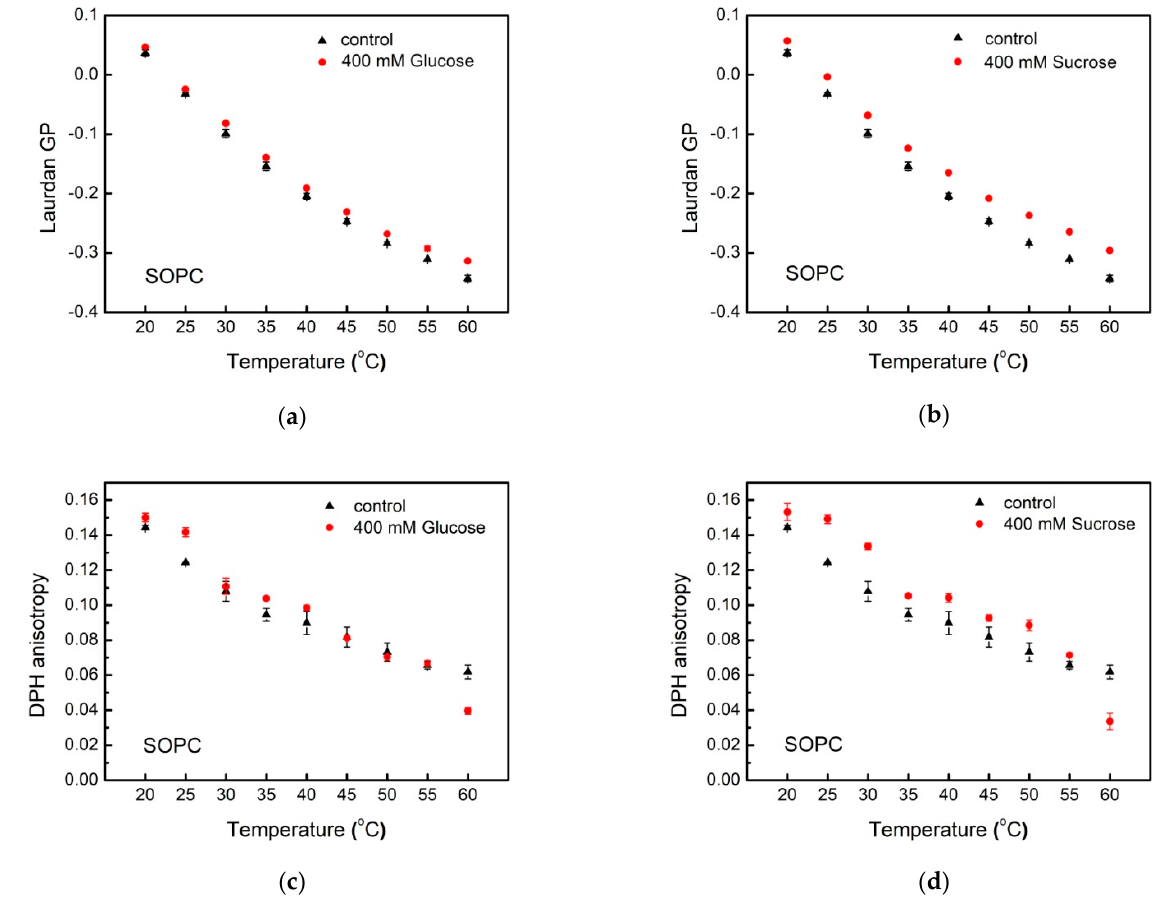
Figure 7. Fluorescence spectroscopy data for SOPC bilayers: Laurdan 𝐺𝑃 as a function of temperature in: ( a ) glucose and ( b ) sucrose solutions; DPH anisotropy vs. temperature in ( c ) glucose and ( d ) sucrose solutions.